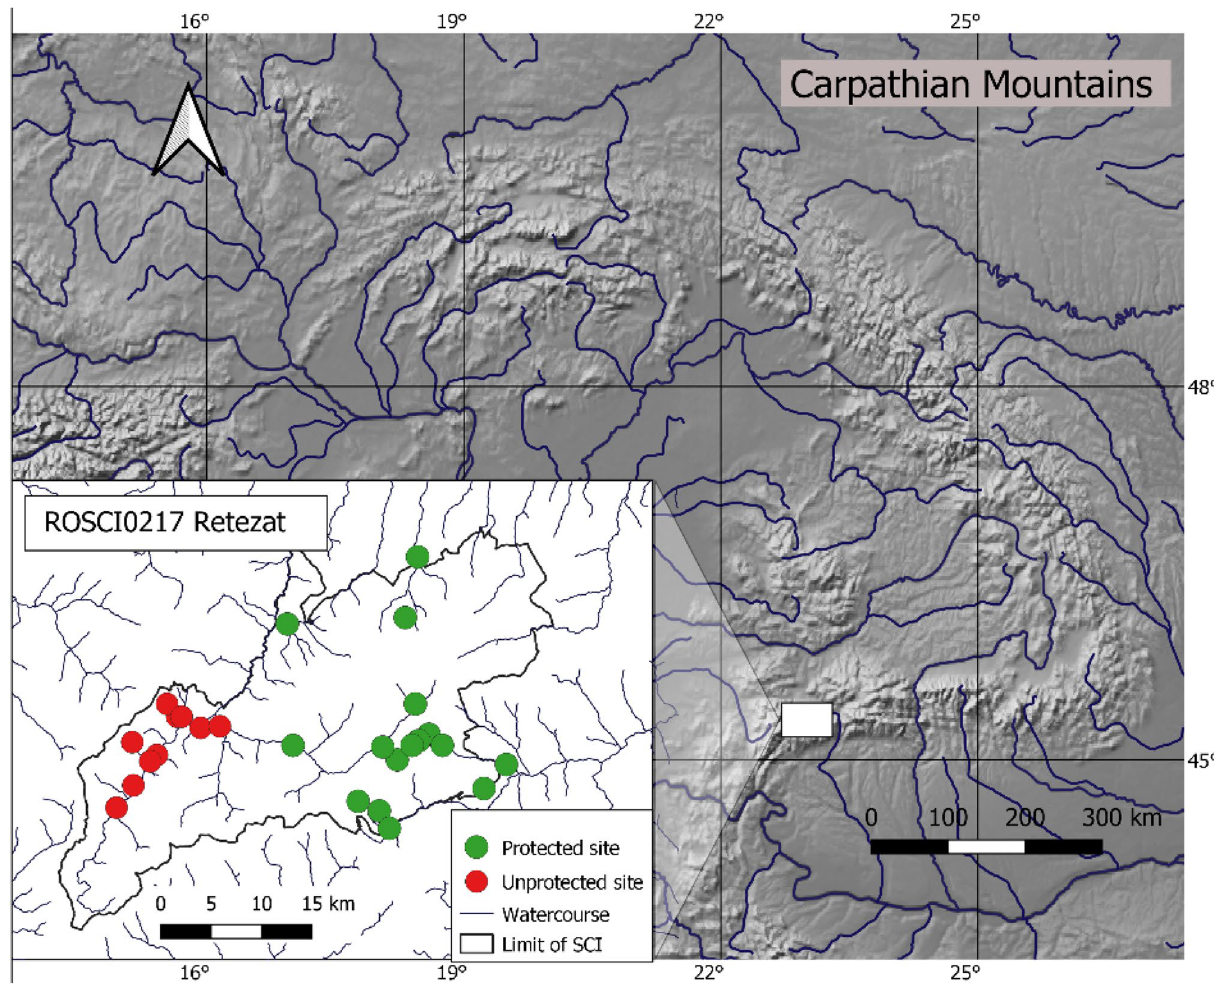
Figure 1. Location of the 26 trapping sites along elevational gradients (820–2040 m) in the Southern Carpathian Mountains of Romania in central Europe. SCI stands for Site of Community Interest, a protected area part of the European Natura 2000 network. The map was made in QGIS 21 with a base map from Natural Earth 22